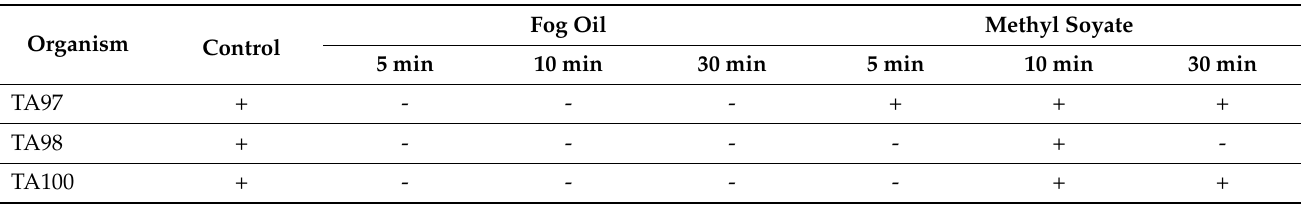
Table 7. Recovery results following aerosol